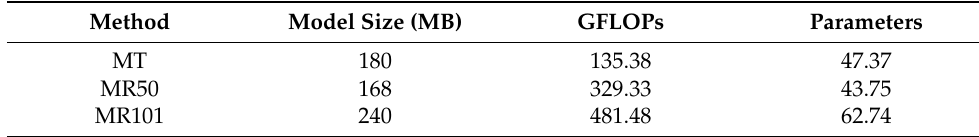
Table 4. Comparison of MR50, MR101, and MT